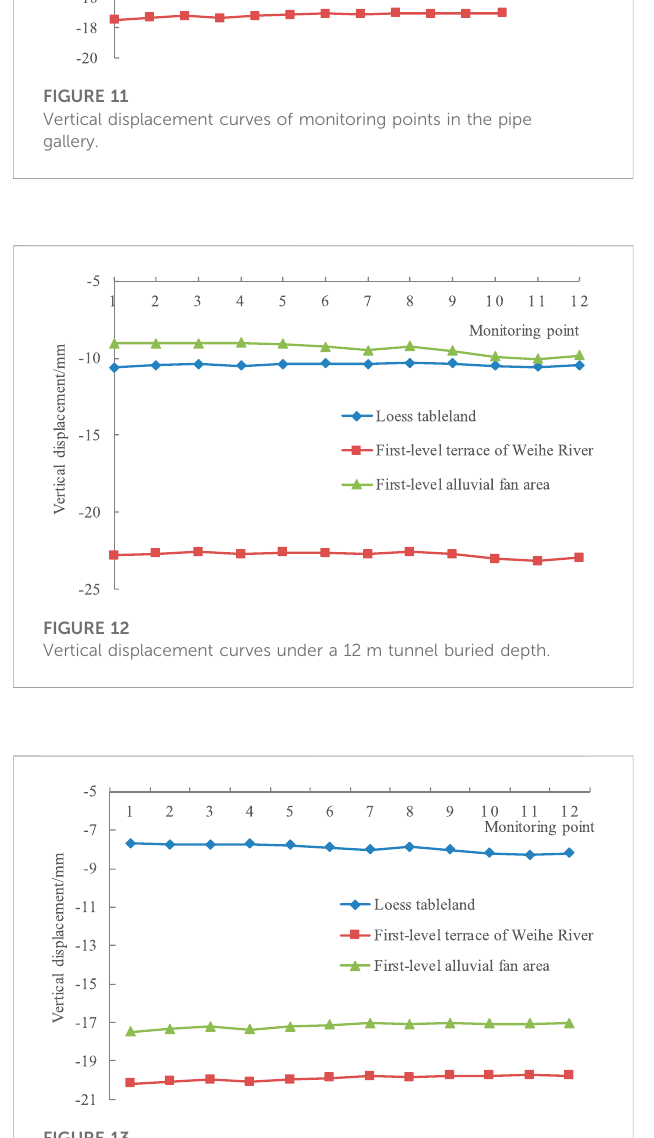
FIGURE 13 Vertical displacement curves under an 18 m tunnel buried depth.